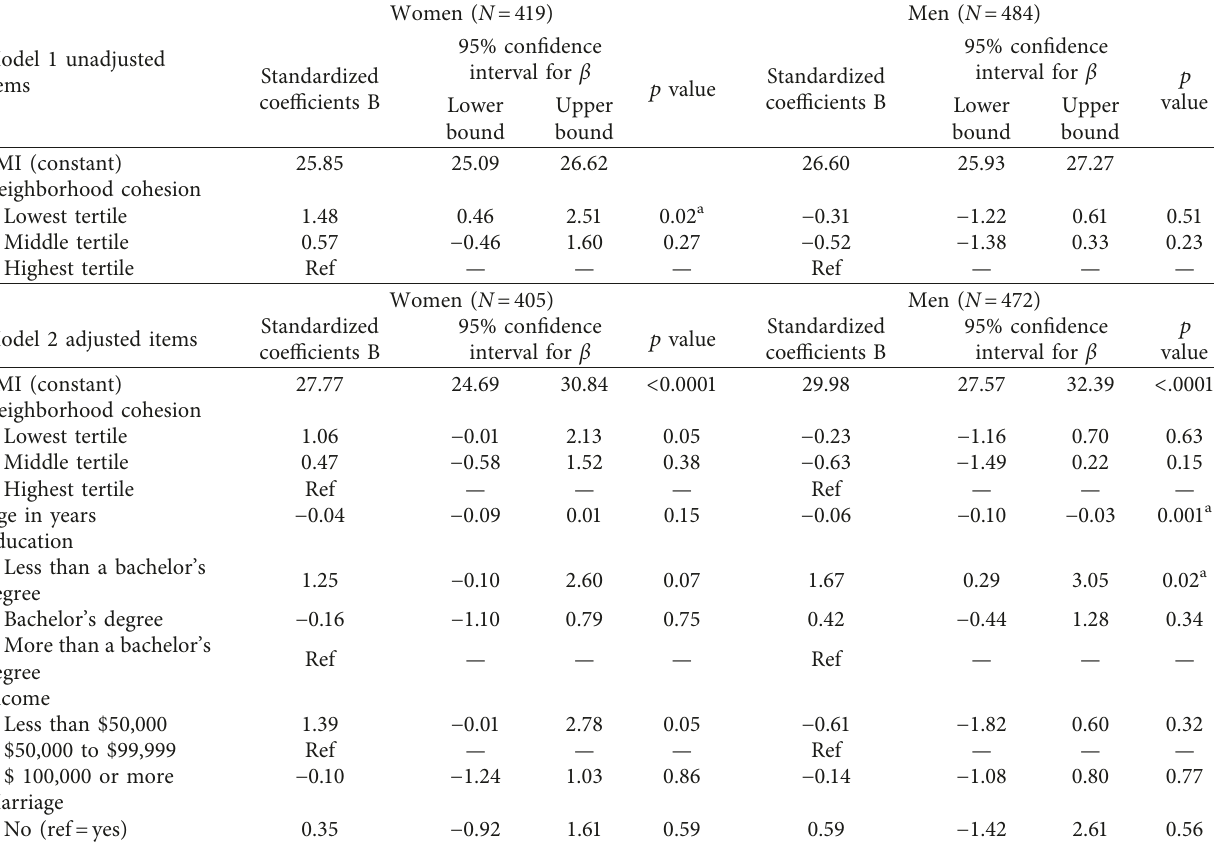
Table 2: Association between neighborhood social cohesion and BMI stratified by sex, MASALA study (2010–2013). Model 1